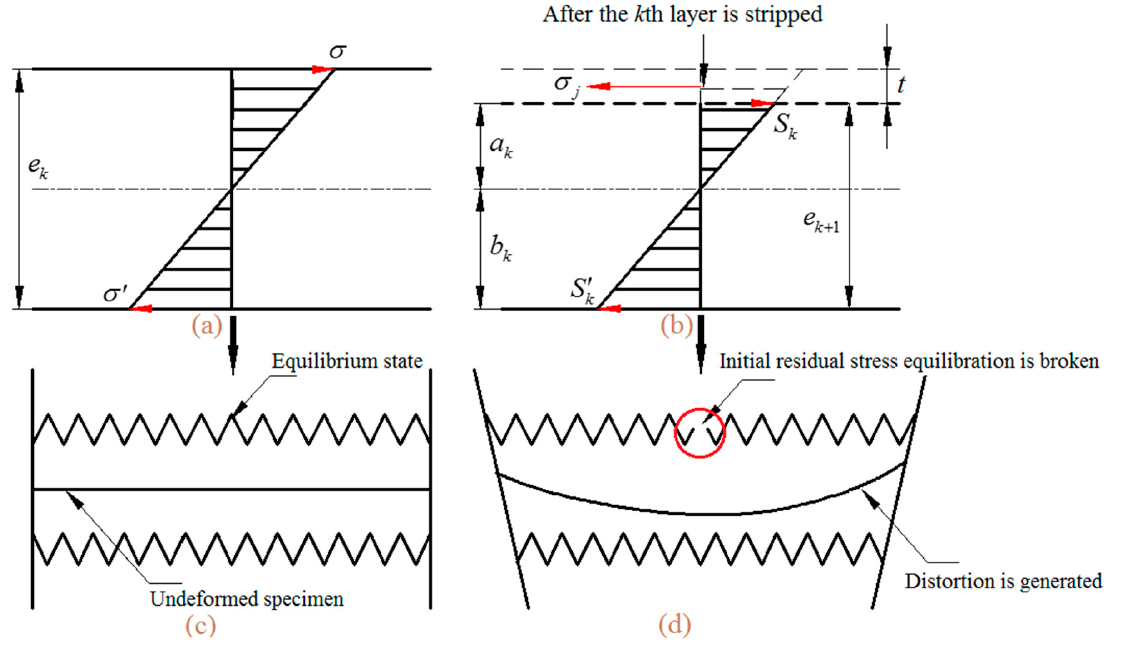
Figure 2. Stress state and deformed condition of the specimen before and after the k th layer is stripped. ( a ) and ( c ) show the equilibrium stress state and undeformed condition; ( b ) and ( d ) the re-equilibrium stress state and deformed condition.